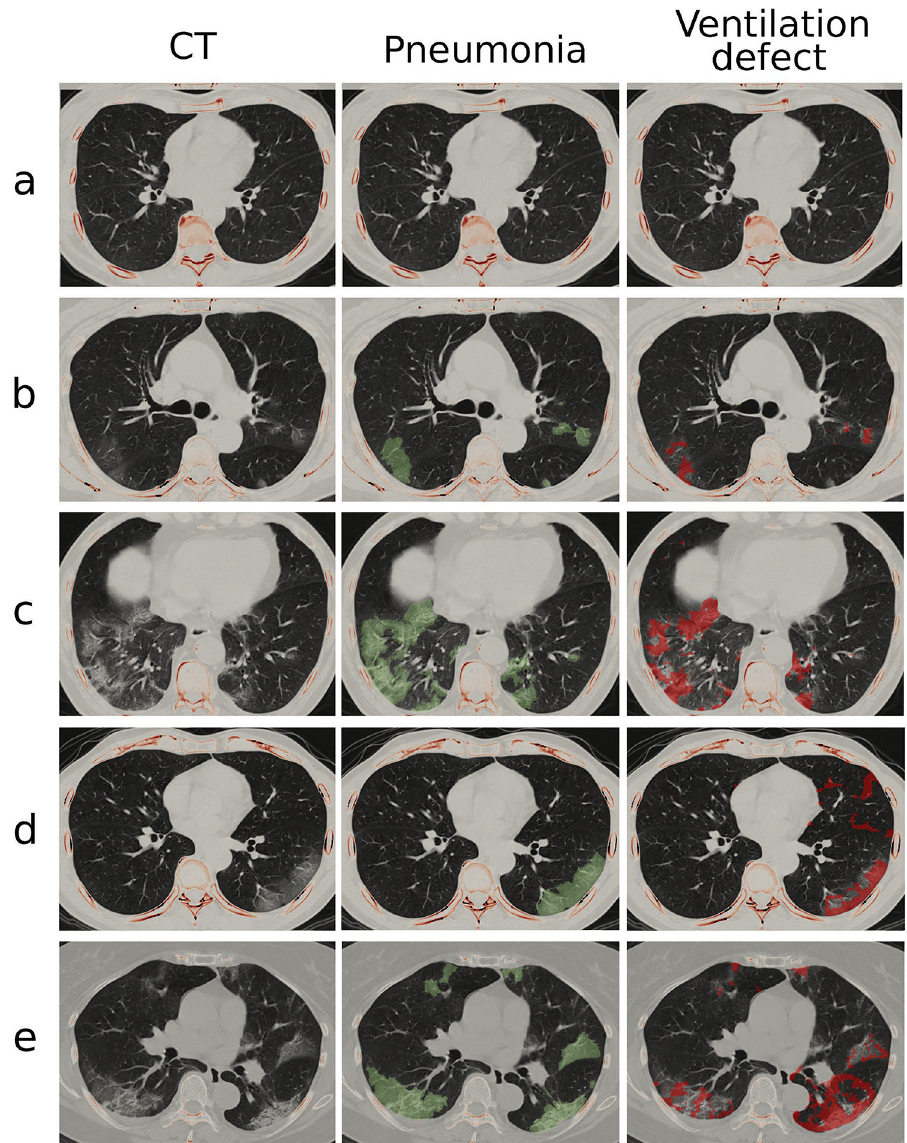
Fig 2. Pneumonia mask and ventilation defect on CT images. The cohort is categorized into (a) normal, (b) COVID-19 asymptomatic, (c) symptomatic without dyspnea and (d-e) symptomatic with dyspnea groups. The middle and right columns show pneumonia mask (green-colored layer) and FAN modeled ventilation defect (red-colored layer) on a transverse plane, respectively. percentage ventilation defect as a classifier of symptoms and dyspnea. The area under the curve (AUC) for the presence of symptoms and dyspnea, the percentage ventilation defect (AUCs, 0.90 and 0.94, each) provided similar diagnostic performances with percentage pneu- monia (AUCs, 0.84 and 0.96, each).